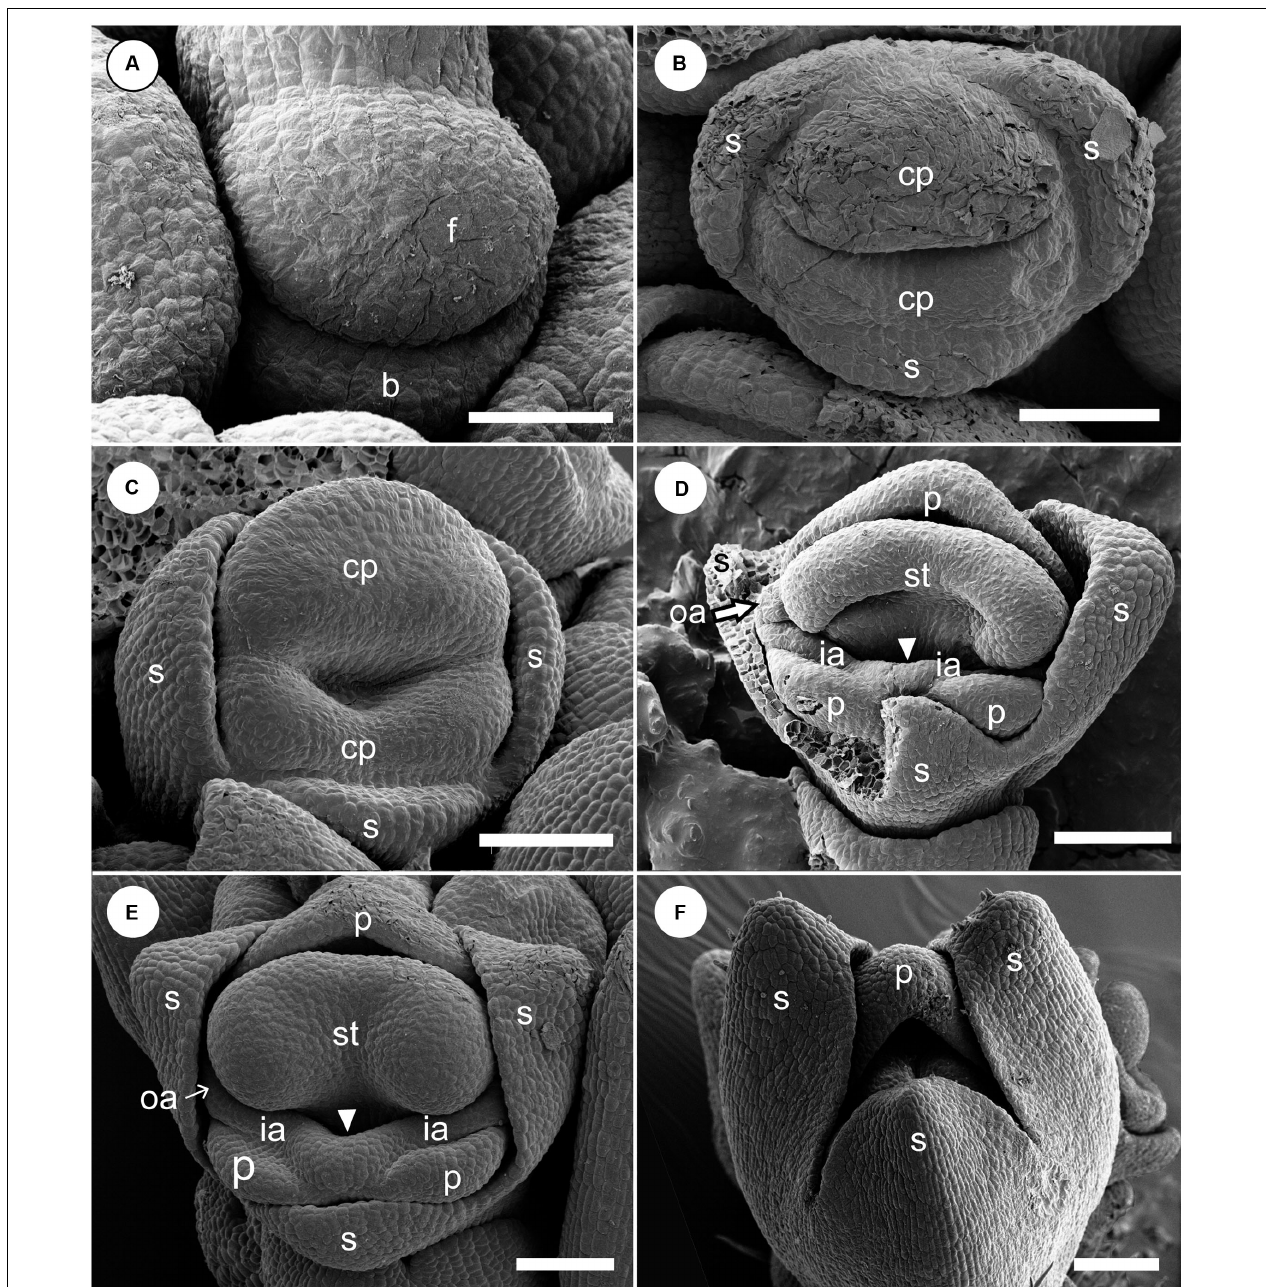
FIGURE 4 | Early floral development of Hemiorchis burmanica. (A) Flower at the earliest stage. Dome-shaped floral bud (f) and bract (b) are initiated. (B) Three sepal primordia (s) and adaxial and abaxial common primordia (cp) are initiated. (C) Two common primordia are fused and form a ring primordium. Three sepals develop. (D,E) Petal (p), stamen (st), and two outer androecial primordia (oa) develop from the adaxial portion of the ring primordium, while two petals and inner androecial primordia develop from the abaxial portion. Note that there is a bump between the inner androecial primordia (ia), which may not be an abaxial outer androecial primordium (see text for details). (F) Three sepal primordia develop and cover the floral apex. b, bract primordium; cp, common primordium; f, floral bud; ia, inner androecial primordium (staminode primordium); oa, outer androecial primordium (staminode primordium); p, petal primordium; s, sepal primordium; st, stamen primordium. Scale bars = (A) 50 µ m, (B–F) 100 µ m.